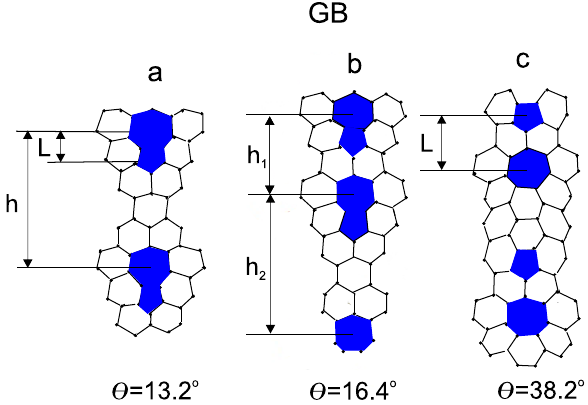
13.2 0.246 nm, ◦ , L = = 38.2 0.42 nm, ◦ , L = =